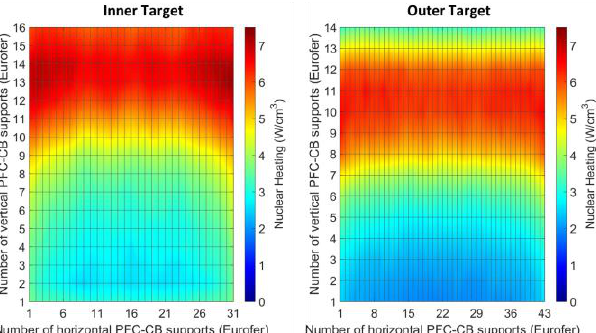
Figure 15. Nuclear heating (W/cm 3 ) distribution on PFC-CB supports (Eurofer) of the inner ( left ) and outer ( right ) target, with WCLL blanket.